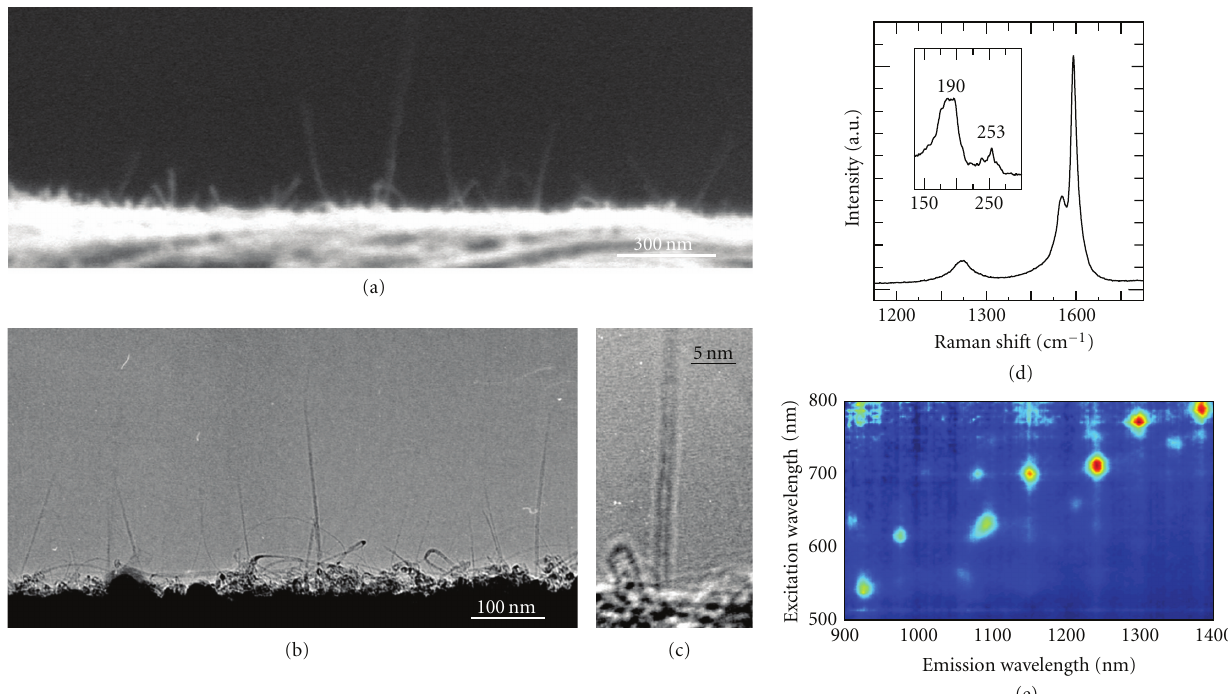
Figure 1: (a) SEM and (b, c) TEM images of freestanding individual SWNTs. (d) Raman scattering spectrum of freestanding individual SWNTs. The inset of (d) shows the RBM region. (e) PLE map from as-grown freestanding SWNTs with no dispersion